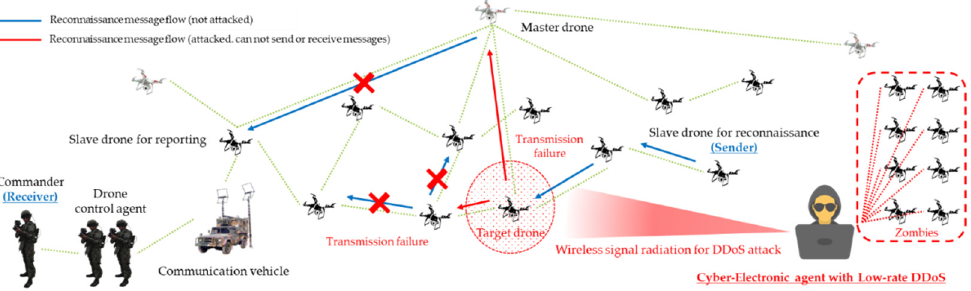
Figure 10. DDoS (distributed denial-of-service) scenario for reconnaissance report in a swarming communication drones maneuvering system.